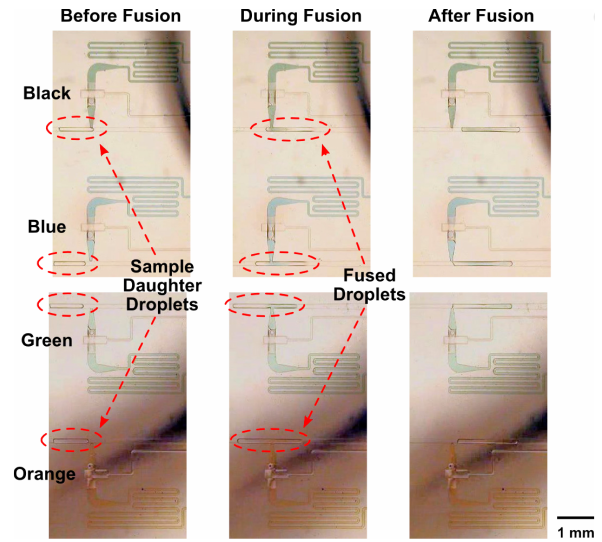
Figure 5. Parallel Fusion of Sample Droplets with Reagent Droplets. In our device, the four split sample droplets (after two bifurcations) maintain an elongated shape as they travel past the four reagent inlets, allowing direct injection of reagents into them for robust droplet fusion simultaneously in all four channels.